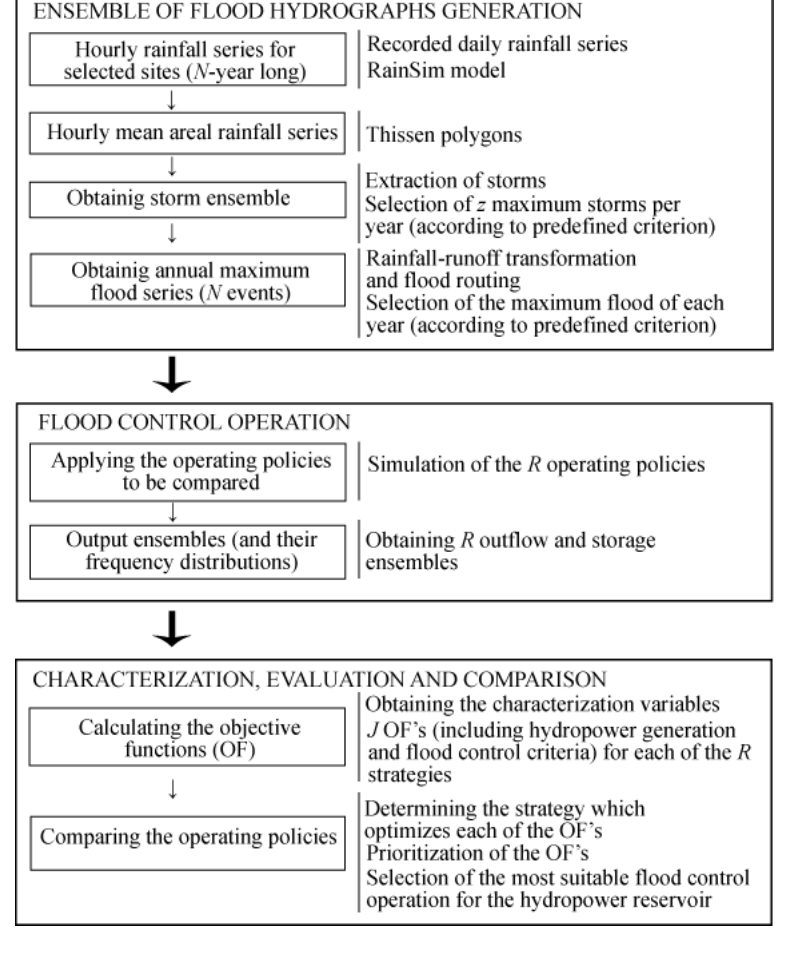
Figure 2. Scheme of the evaluation and comparison